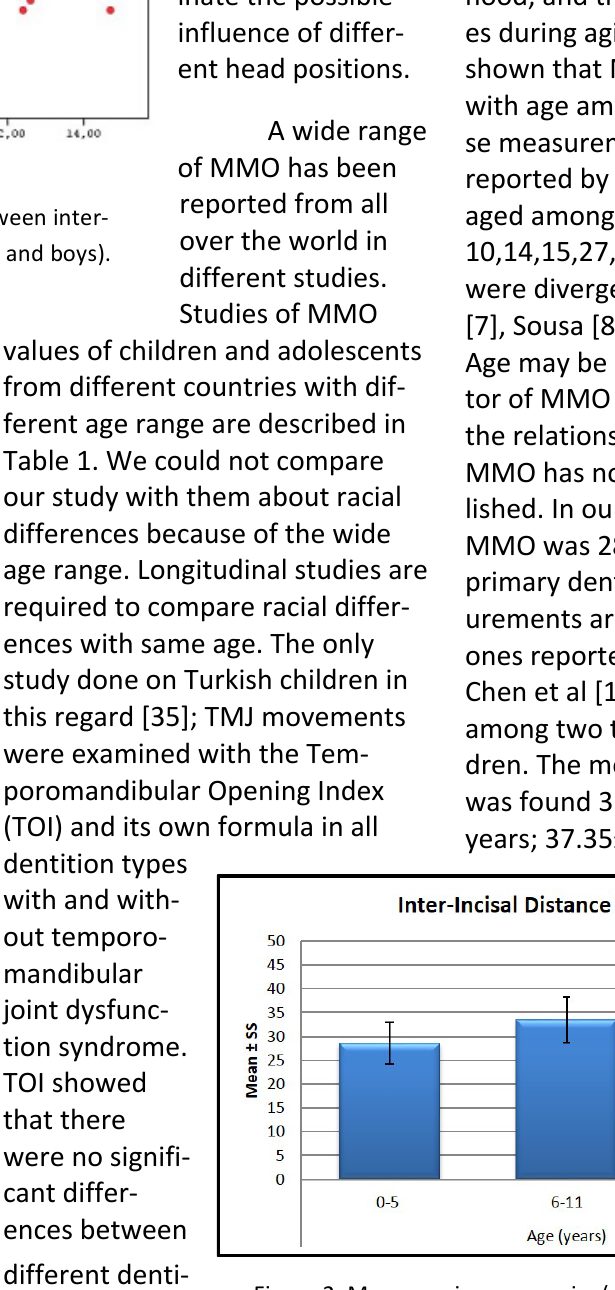
Figure 2. Mean maximum opening(mm) by age